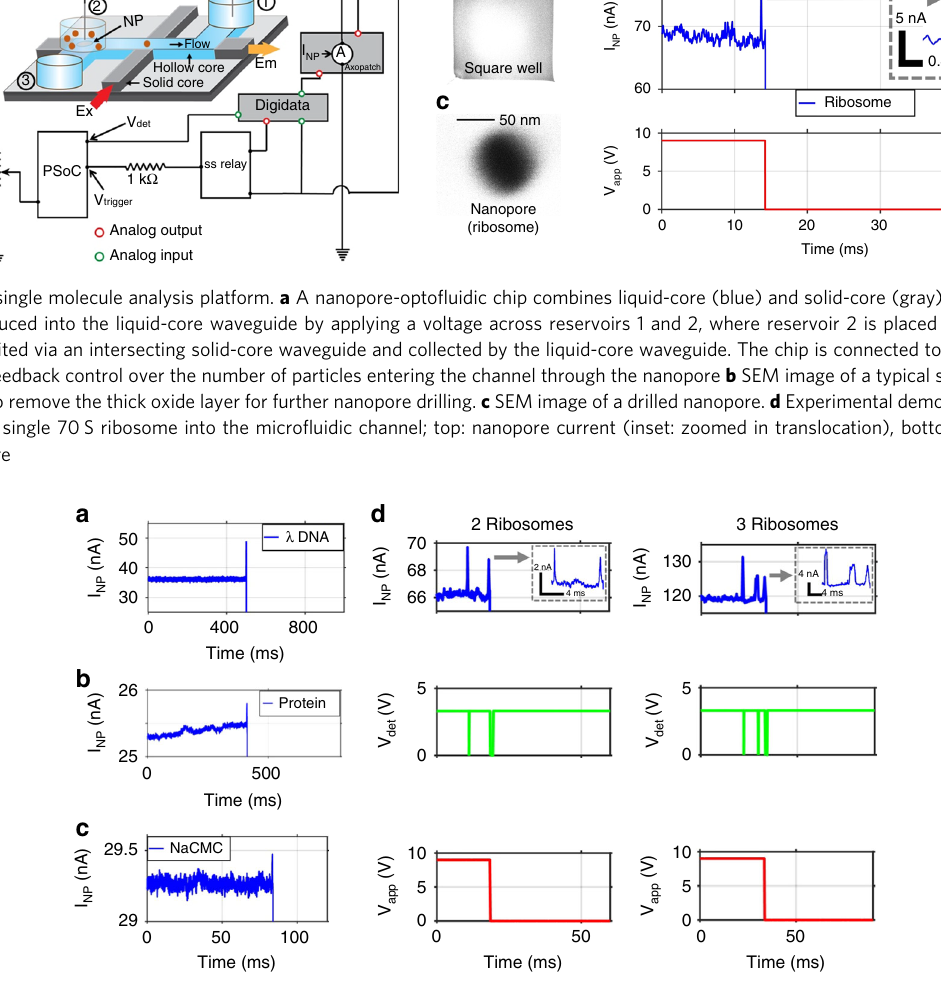
Fig. 2 Gated delivery of single bioparticles with recon fi gurable settings. a – c Current trace of voltage-gated delivery of single λ -DNA, Zika NS-1 protein, and NaCMC molecule respectively, into the micro fl uidic channel. d Example of delivery of user-de fi ned particle number (here: two and three) into fl uidic channel (top: current through pore (inset: zoomed in translocations); center: signals in detection circuit of digitized identi fi cation of particle translocation; bottom: voltage across pore turned off after the desired number of particles has been